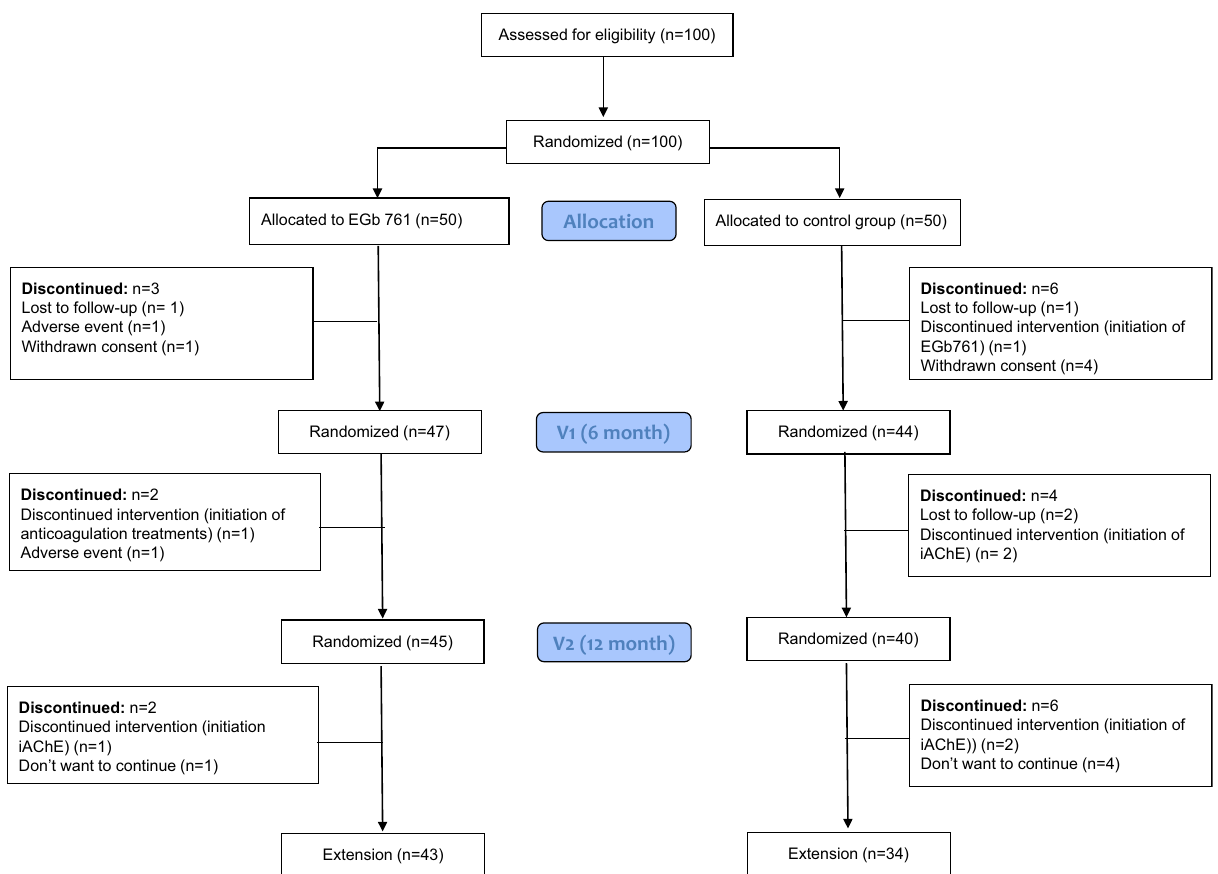
Figure 2. Flow of patients through the